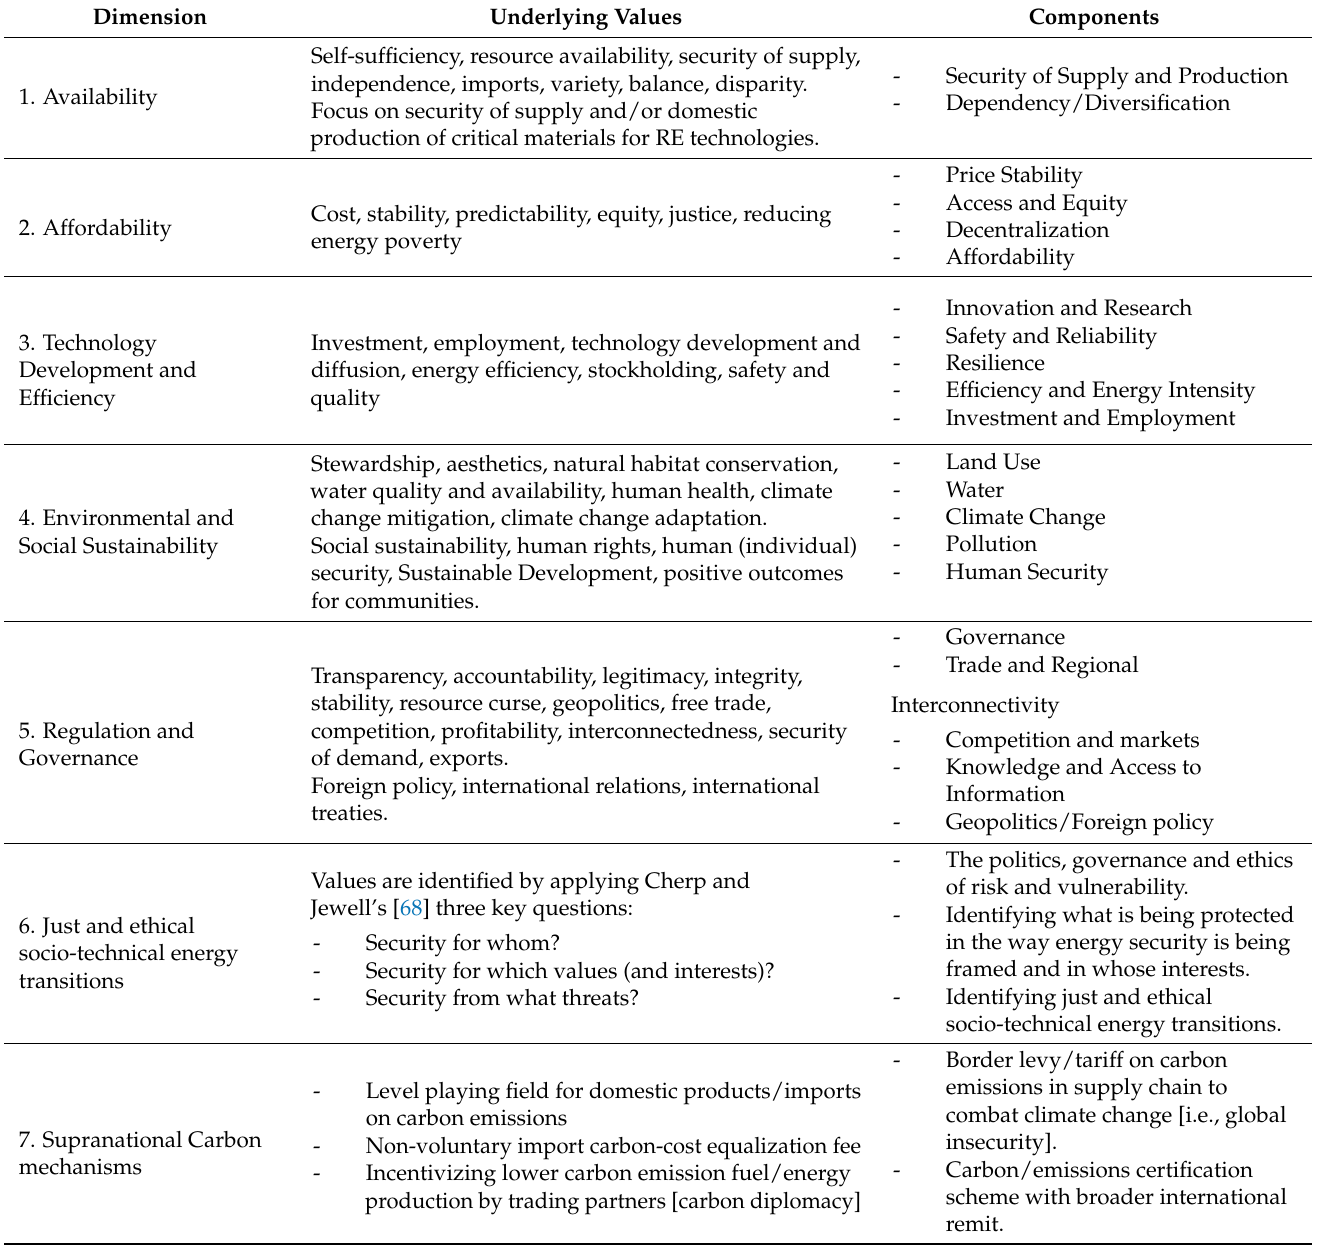
Table 1. Applied seven-dimension energy security-justice